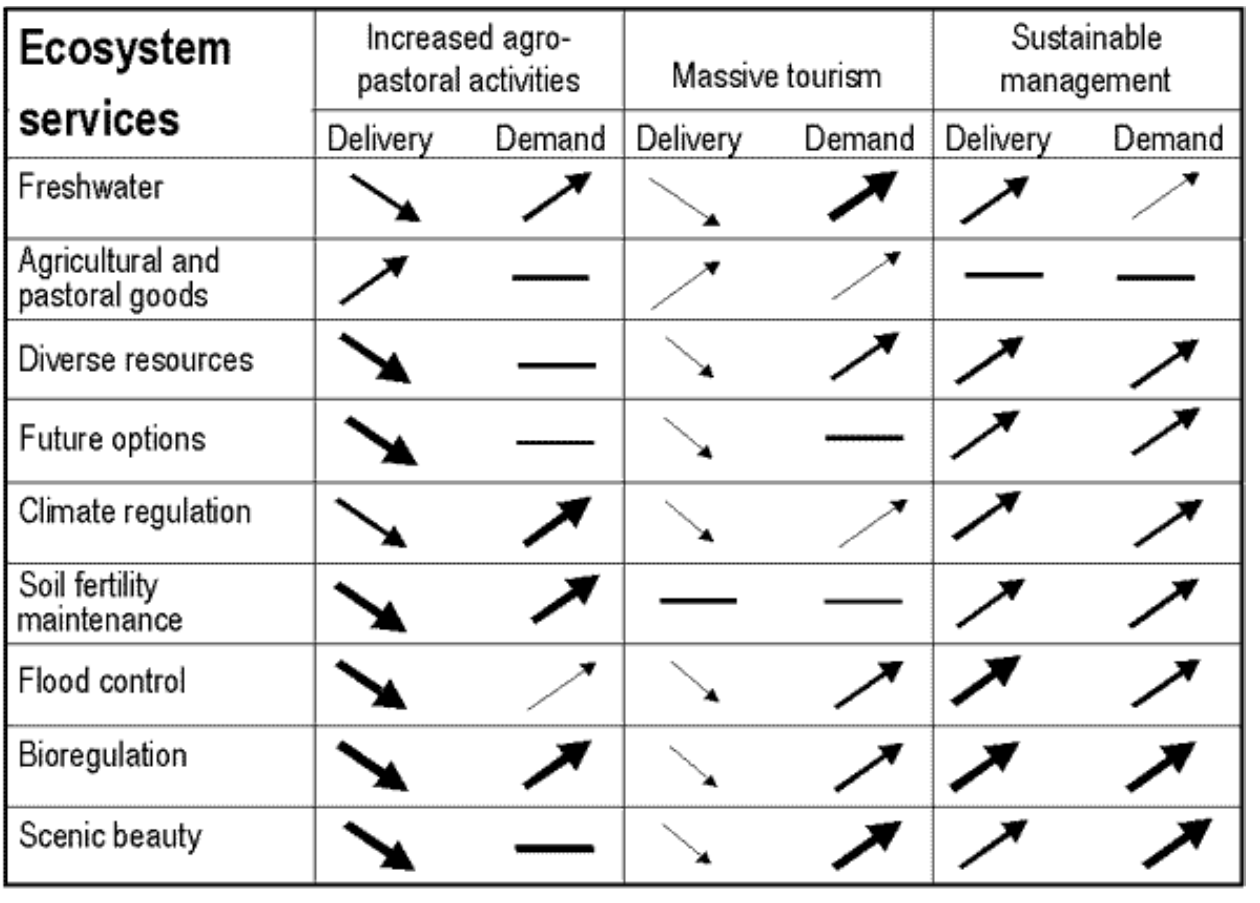
Fig. 7. Expected delivery and demand of ecosystem services from a tropical dry forest region of western Mexico for three alternative future scenarios. Directions of arrows indicate increases or decreases. Arrow widths specify the intensity of such a process (wider arrows mean a stronger increase or